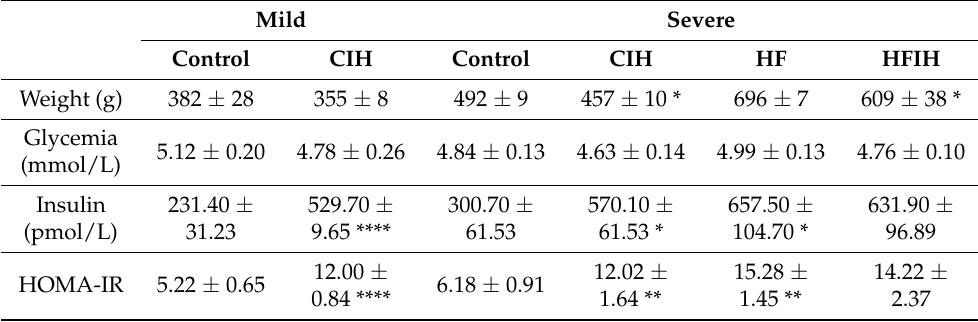
Table 1. Effect of mild and severe chronic intermittent hypoxia (CIH) exposure on weight, fasting glycemia, fasting insulinemia, and insulin resistance calculated by the homeostatic model assessment (HOMA-IR) method in control and high-fat (HF) animals. Mild Severe Control CIH Control CIH HF